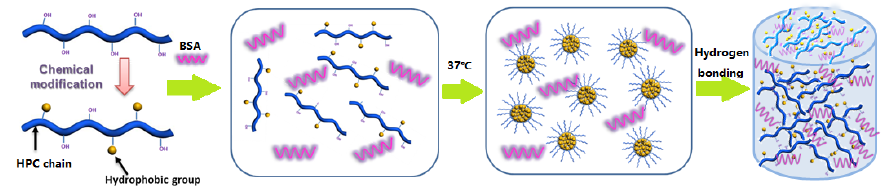
Figure 3. The scheme of the formation mechanism of HPC- g -AA/BSA hydrogels.